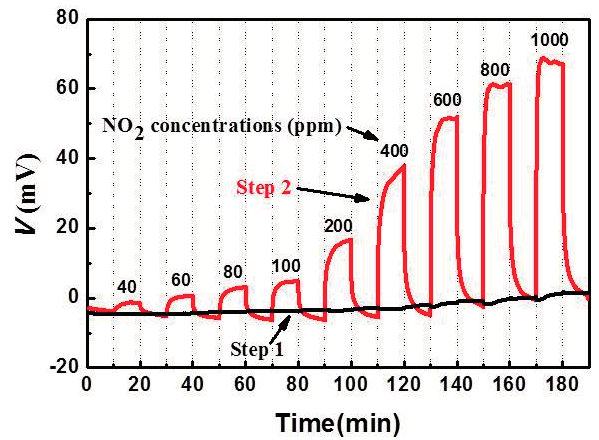
Figure 13. Sensing characteristics of SE and RE for S-LSM95 sensors measured at 500 °C in the two-chamber